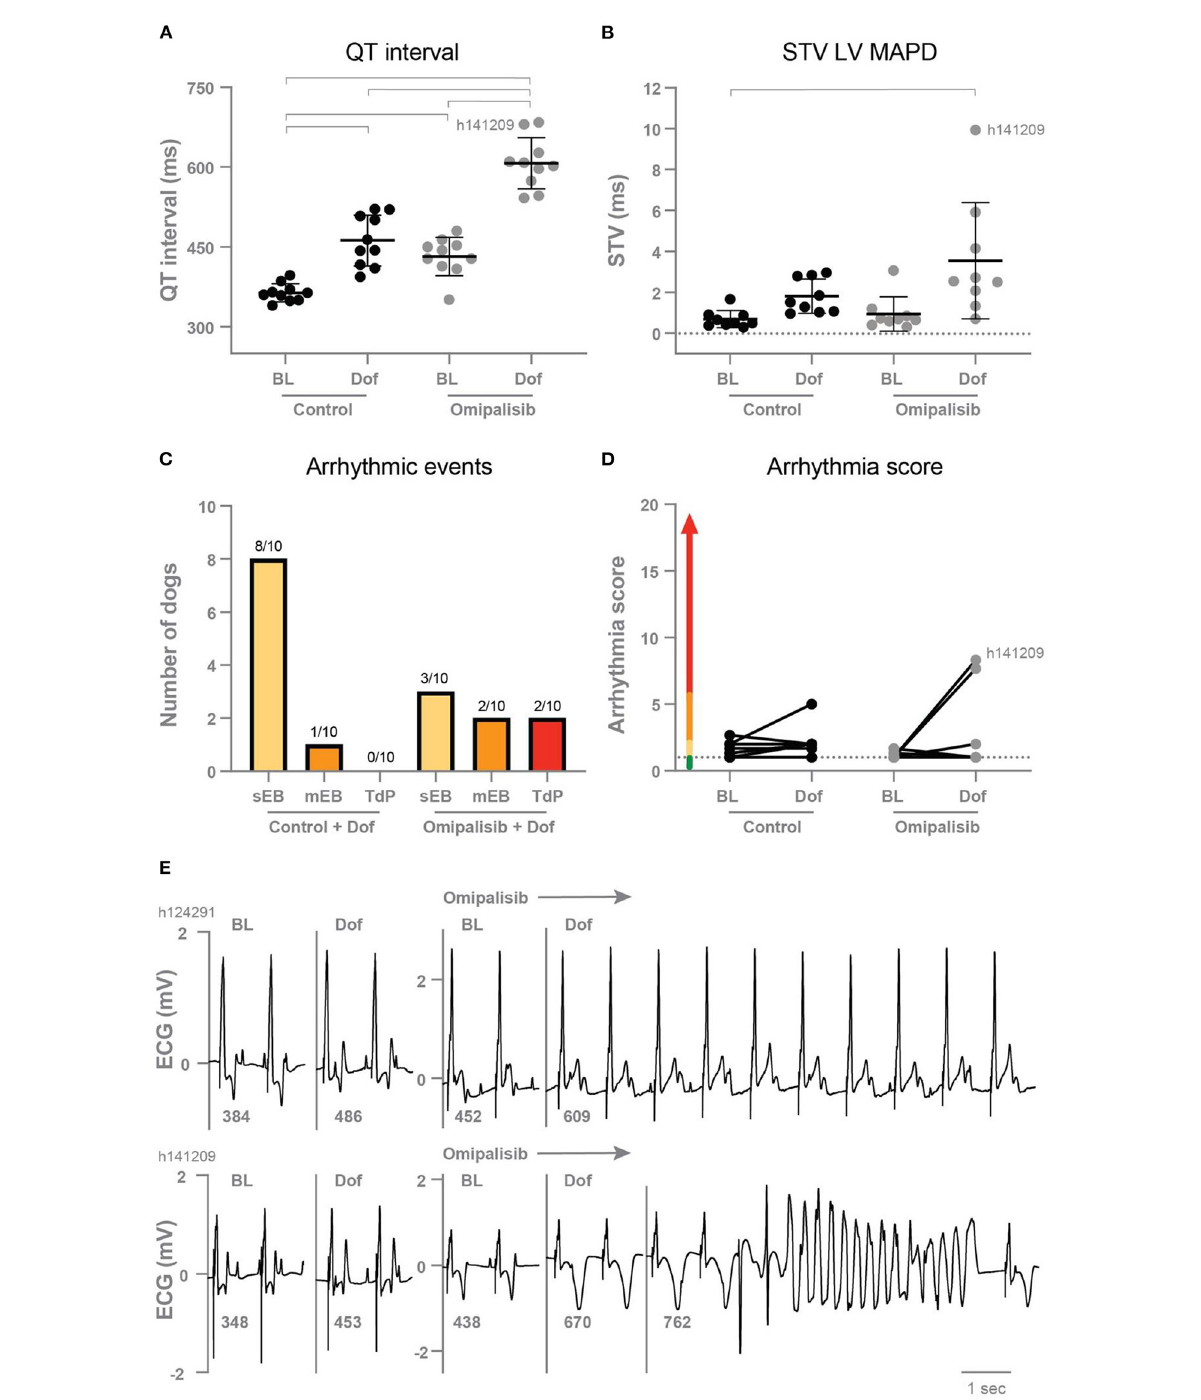
FIGURE4 (A) QT interval ( n 10) and (B) short term variability of repolarization (STV LV MAPD, n 9) in dogs before (Control) and after 1 mg/kg omipalisib = = twice a day during baseline (BL) and dofetilide (Dof). Data are presented as mean SD. Repeated measures two-way ANOVA with Tukey’s ± multiple comparisons test, bars refer to p < 0.05. (C) Incidence of arrhythmic events and (D) arrhythmia score during 10min after start of Dof before and after omipalisib treatment. Single ectopic beats (sEB, score: 2 points), multiple ectopic beats (mEB, scored with 3–5 points), and Torsade de Pointes (TdP) arrhythmia (scored with 6–49 points). TdP arrhythmia demanding defibrillation were scored with 50, 75 or 100 points depending on the number of shocks. (E) ECG lead II of the two dogs: h124291 with arrhythmia score of 1, and h141209 with a self-terminating TdP arrhythmia and arrhythmia score of